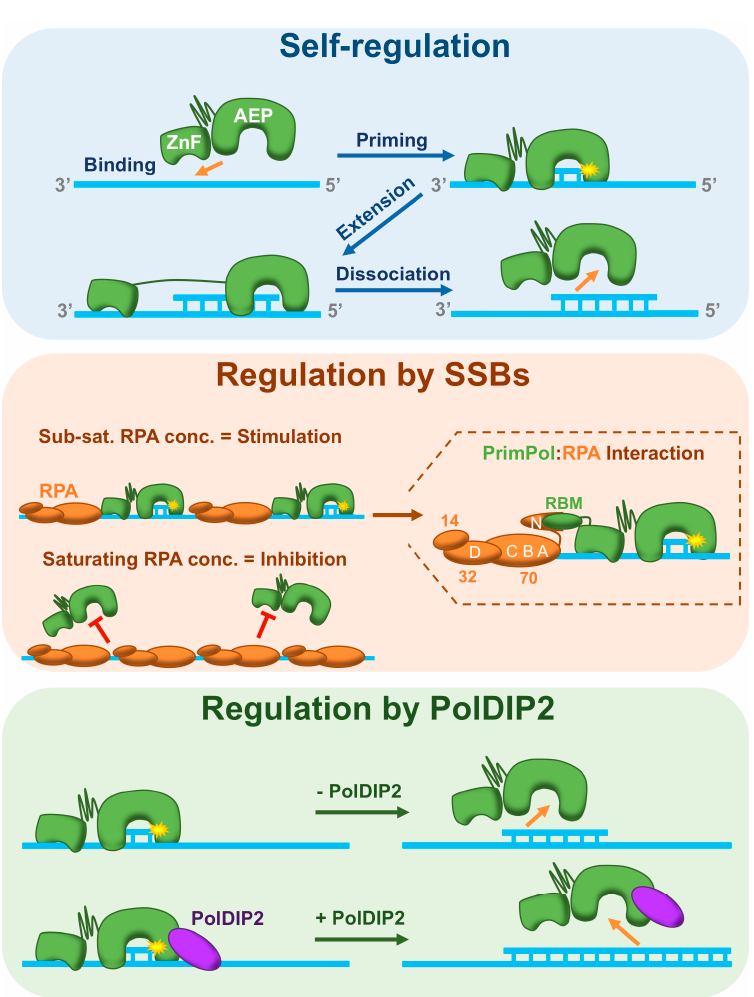
Figure 3. Regulation of PrimPol by its ZnF domain and interacting partners. Top panel : PrimPol is inherently self-regulatory due to the restraining effect of its ZnF domain. The AEP and ZnF domains of PrimPol form a hinge-like structure, connected by a flexible linker. Binding of PrimPol to ssDNA is mediated by the ZnF domain, which binds 3’ relative to the AEP domain on the template strand. Binding of the ZnF stabilises the AEP domain, permitting primer synthesis. The AEP then extends the primer, but is restricted by the maximum distance it can move away from the ZnF. The enzyme subsequently dissociates leaving behind a short primer. This mechanism limits the processivity of the PrimPol; Middle panel: PrimPol is regulated by single-strand binding proteins (SSBs). At sub-saturating concentrations of RPA, the protein acts to recruit PrimPol to the ssDNA template,